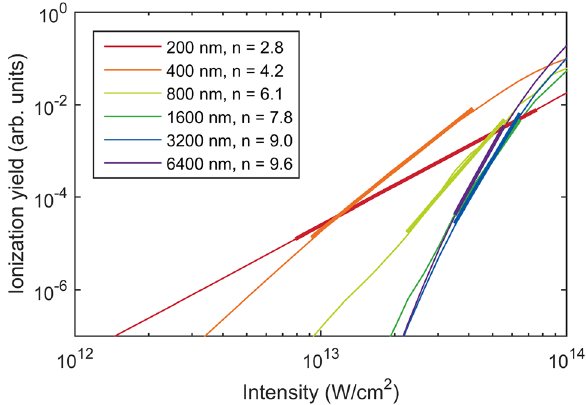
Figure 1. Nonlinear coefficient n calculated using laser pulses at various center wavelengths. Ionization yields (thin solid lines) were calculated using laser pulses with a duration of 3 optical cycles by solving TDSE in 1D at different intensities and wavelengths. The nonlinear coefficient n was obtained by fitting the ionization yields in 2 5 10 the range of 10 − (thick solid − −